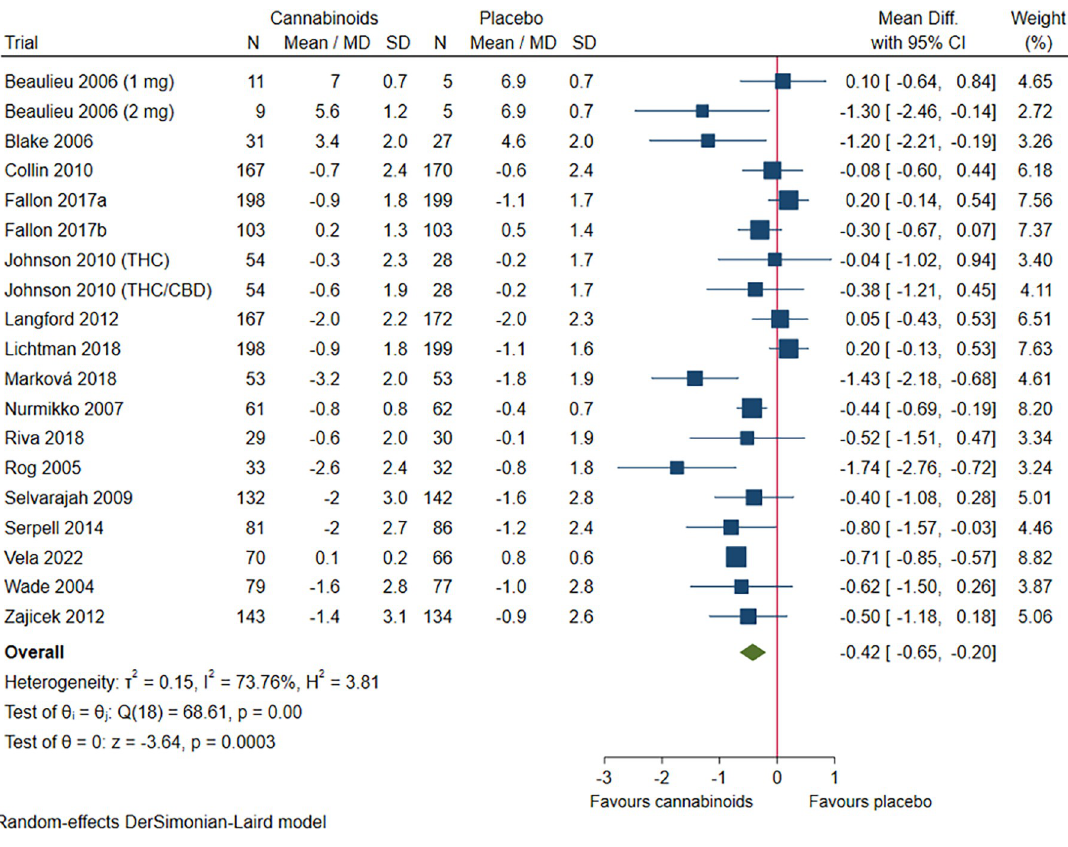
Fig 5. Forest plot of the meta-analysis of quality of sleep with 95% CI. Depressive symptoms. Five trials randomising 651 participants assessed depressive symp- toms using either HADS-D (3 trials), MADRS (1 trial) or BDI-II (1 trial). Meta-analysis showed no evidence of a difference between cannabinoids versus placebo (mean difference -0.03; 95% CI -0.12 to 0.06; P = 0.49; low certainty of evidence; S51 Fig in S1 File ). Visual inspection of the forest plot and I 2 -statistic (I 2 = 0%) and tau 2 statistic ( τ 2 = 0.00) indicated low heterogeneity. TSA showed that there was enough information to reject that cannabinoids ver- sus placebo improved depressive symptoms ( S52 Fig in S1 File ). We assessed this outcome result at high risk of bias, see ‘ Supplement 4 in S1 File ’.